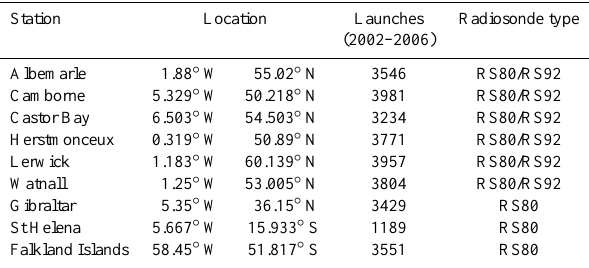
Table 1. A summary of UK Met Office high resolution radiosonde observations (1 January 2002–31 December 2006) used in this study. Observations were generally performed using the Vaisala RS80 up to mid-2005 with the RS92 instrument used thereafter (UK Meteorological